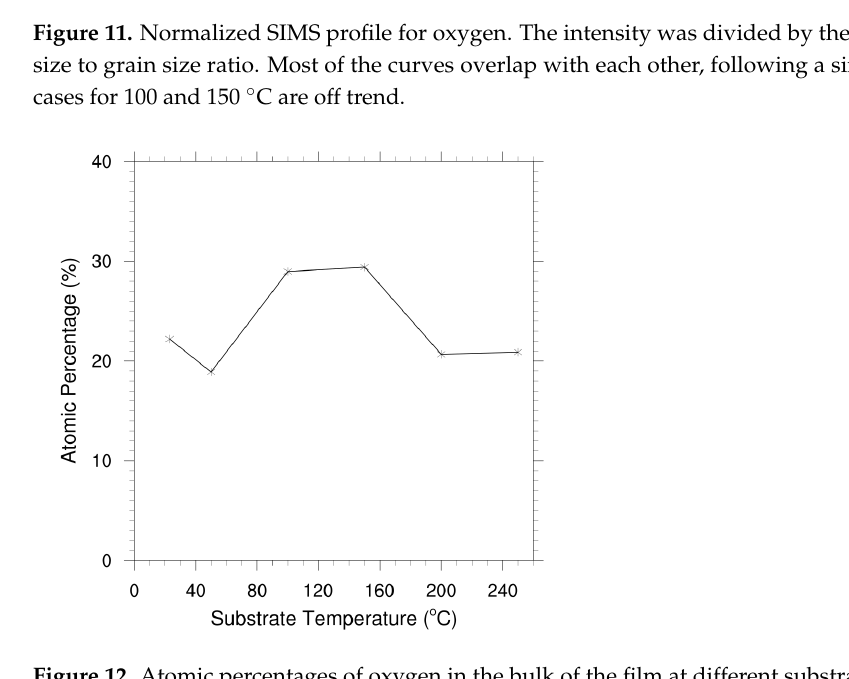
Figure 12. Atomic percentages of oxygen in the bulk of the film at different substrate temperatures as determined by XPS